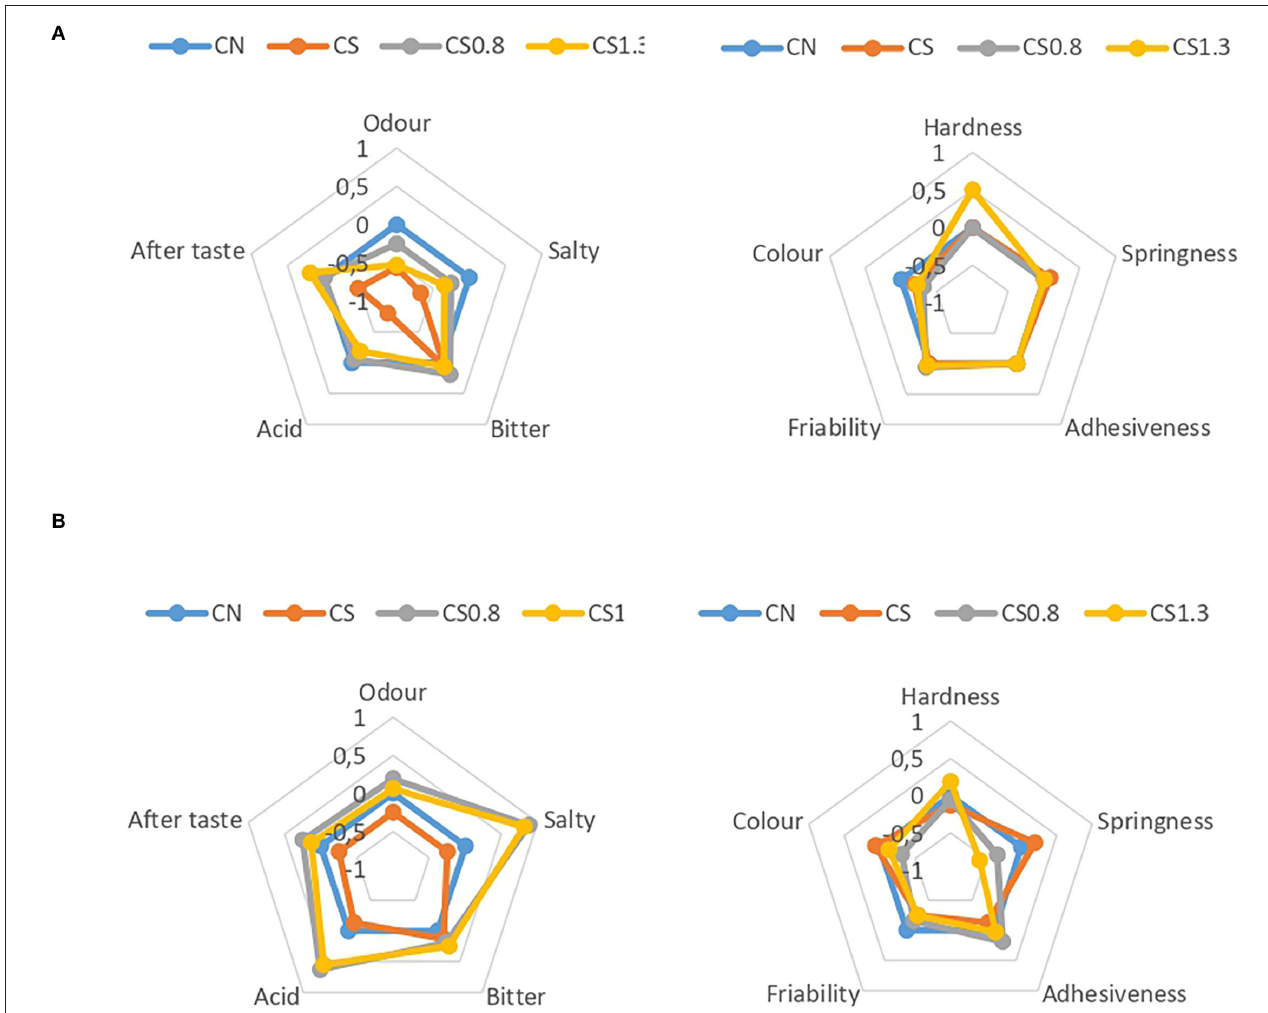
FIGURE 2 | Results of sensorial analysis of reduced-Na cheeses by substituted-Na treatment (CS) at 30 days (A) and 60 days (B) of ripening.